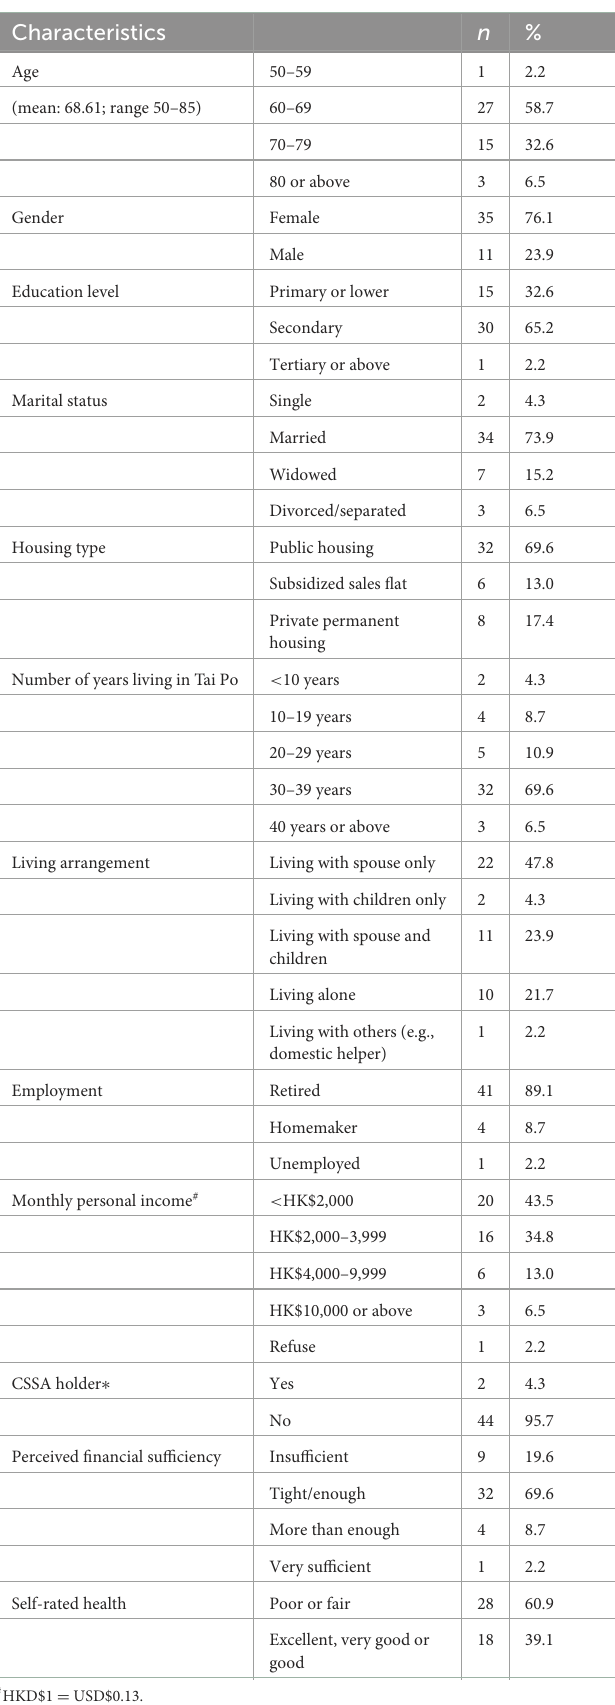
TABLE 1 Demographic characteristics of the older adult participants ( n =